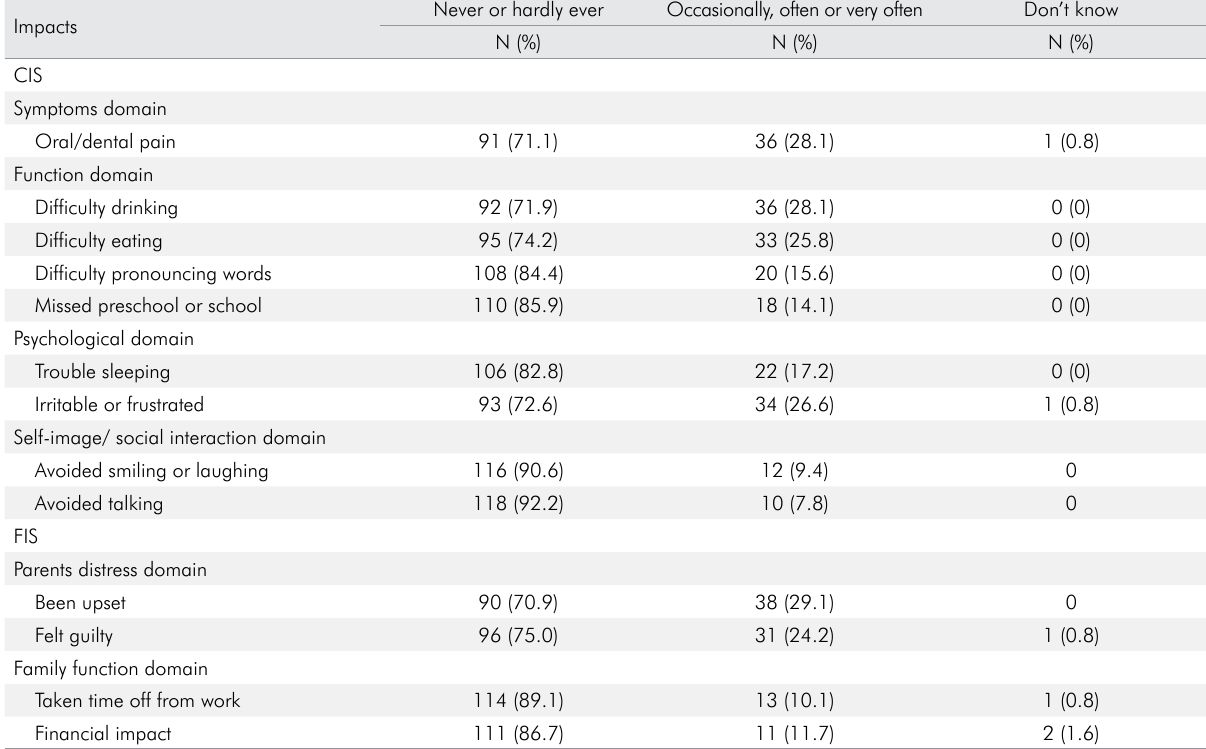
Table 1. Distribution of B-ECOHIS answers given by parents in population-based sample.